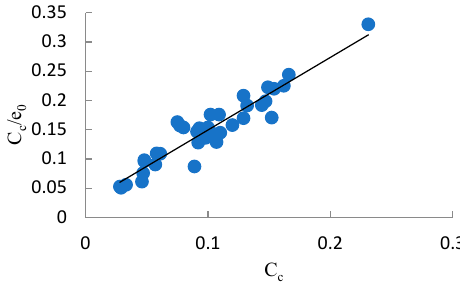
Figure 6. Correlation diagram of C c /e 0 and C c in soil.